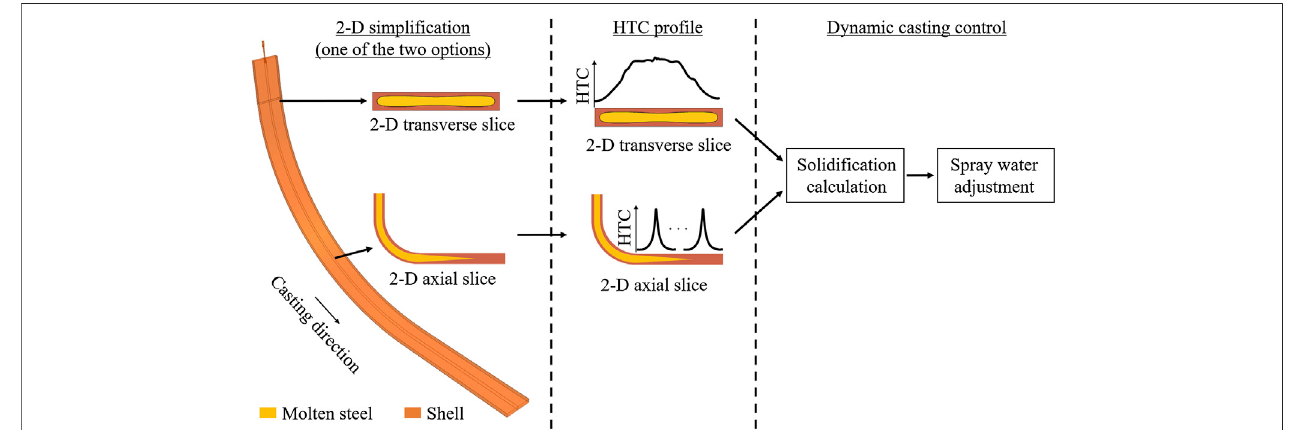
FIGURE 1 | The typical control scheme of continuous